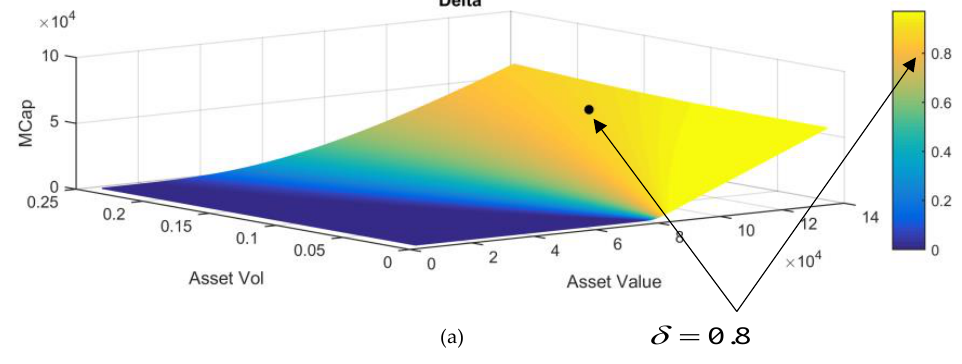
and ( b ) Vega, or υ = ∂ MCap AssetsMCap  AssetsMCap  ∂ Assets ∂ AssetVol  and (b) Vega, or  and (b) Vega, or